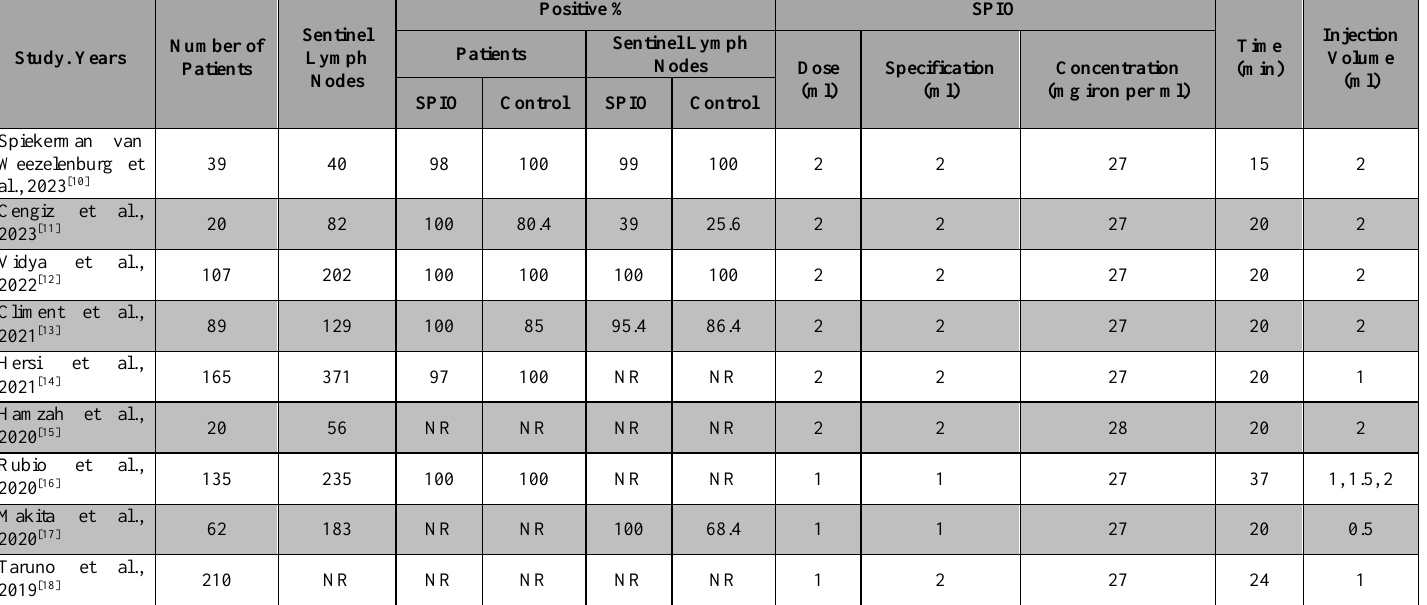
Table 2. Demographic information extracted from the full text of the selected